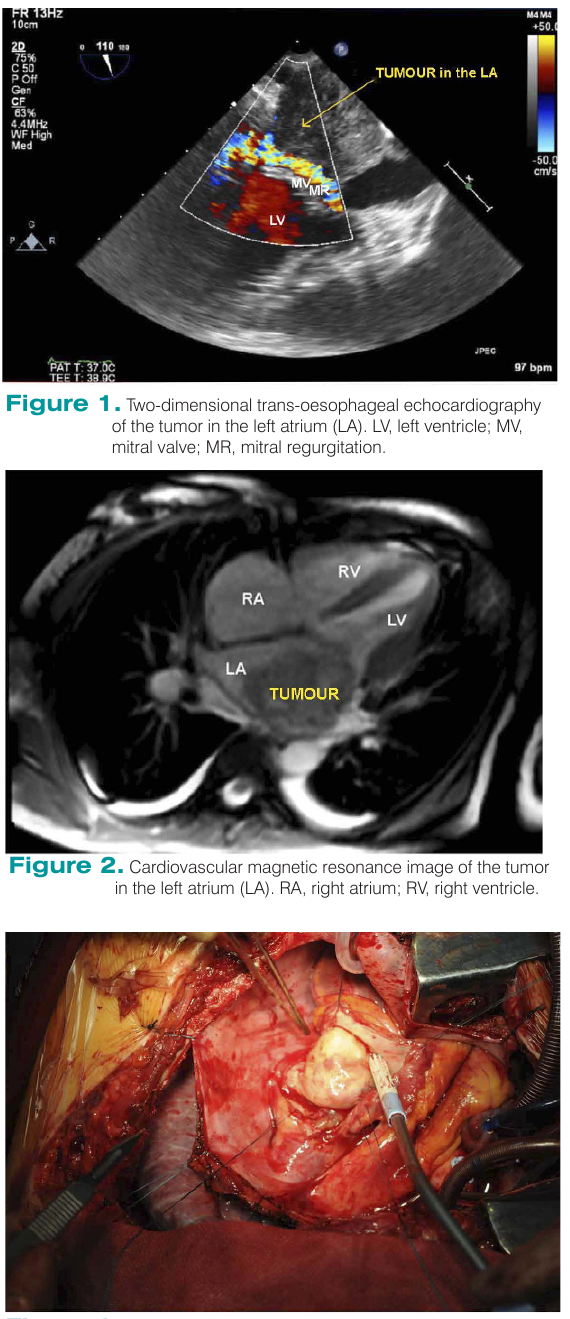
Figure 3. Intraoperative image of the tumor in the left atrium.